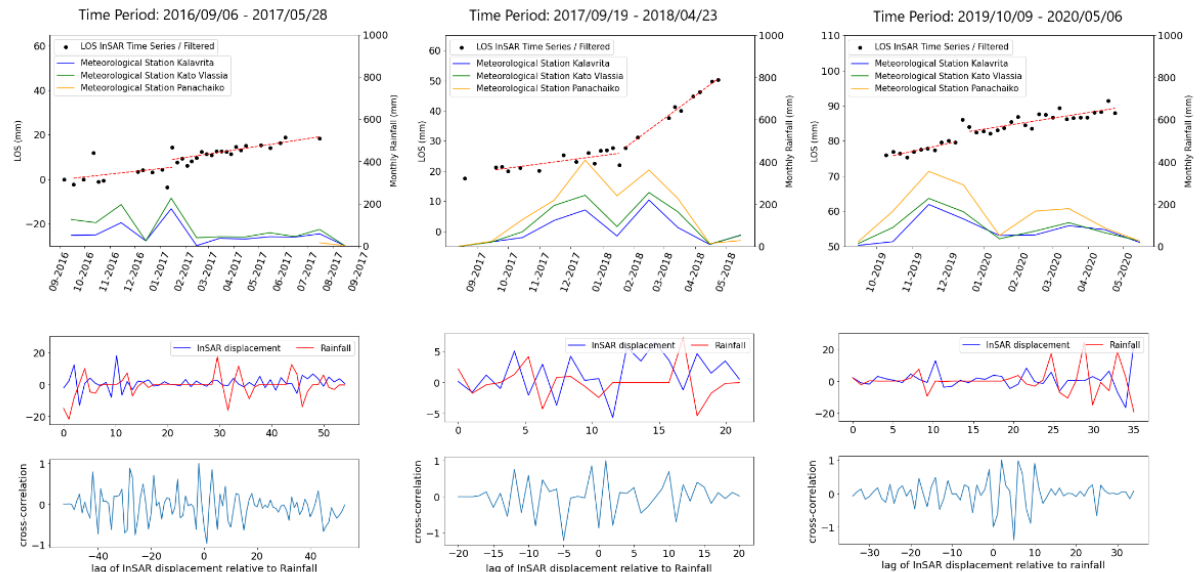
Figure 11 . Graphs showing InSAR position time series and average monthly rainfall (Kato Vlassia station, top panel) for each time period corresponding graphs showing cross-correlation results (signal-converted waveforms, middle panel; correlation between the two waveforms, lower panel). The corresponding displacement rates are reported in Table 2. Table 2 . Displacement rate A corresponds to the linear displacement rate of the Krini landslide (descending orbit) before the maximum seasonal rainfall is reached, and linear displacement rate B corresponds to the displacement rate following the rainfall peak (see Figure 11 for trendlines). The total rainfall corresponds to the total rain during each time period. The displacement rate A & B values of the last line (period 2020–2021) refers to the ascending orbit data.